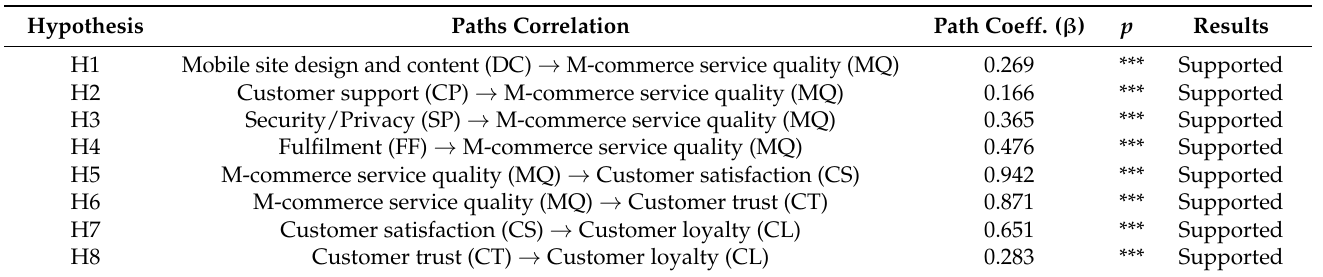
Table 7. Hypothesis (H) testing